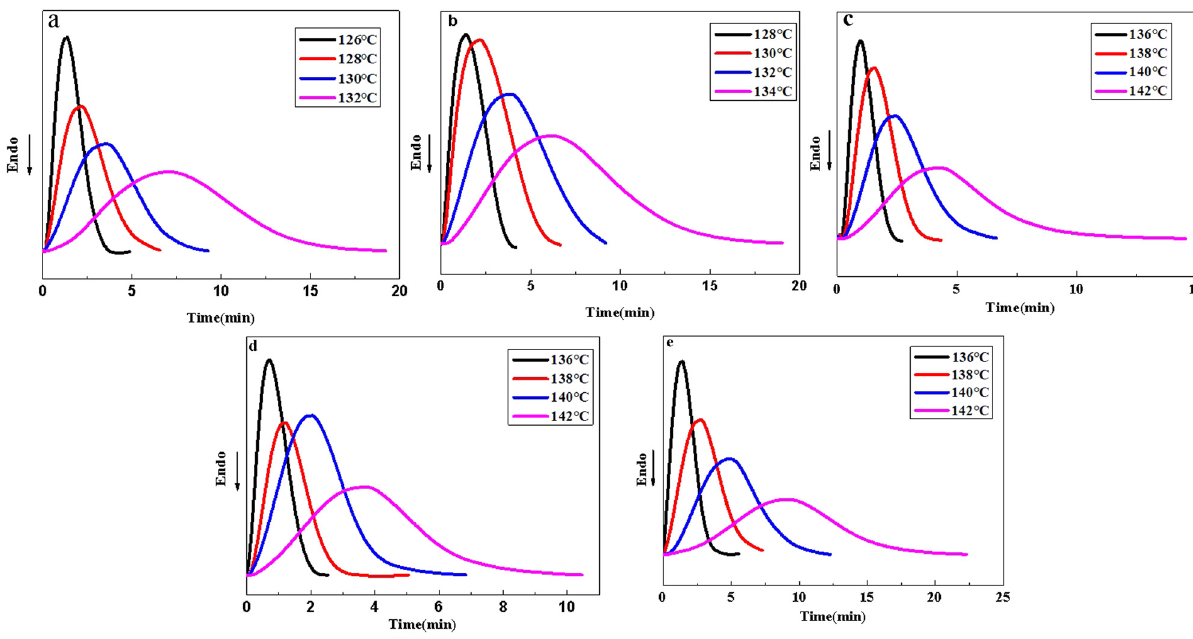
Figure 6: Isothermal crystallization curves of ( a ) iPP, ( b ) iPP/S0, ( c ) iPP/S1, ( d ) iPP/S2, and ( e ) iPP/S3 at di ff erent temperatures.